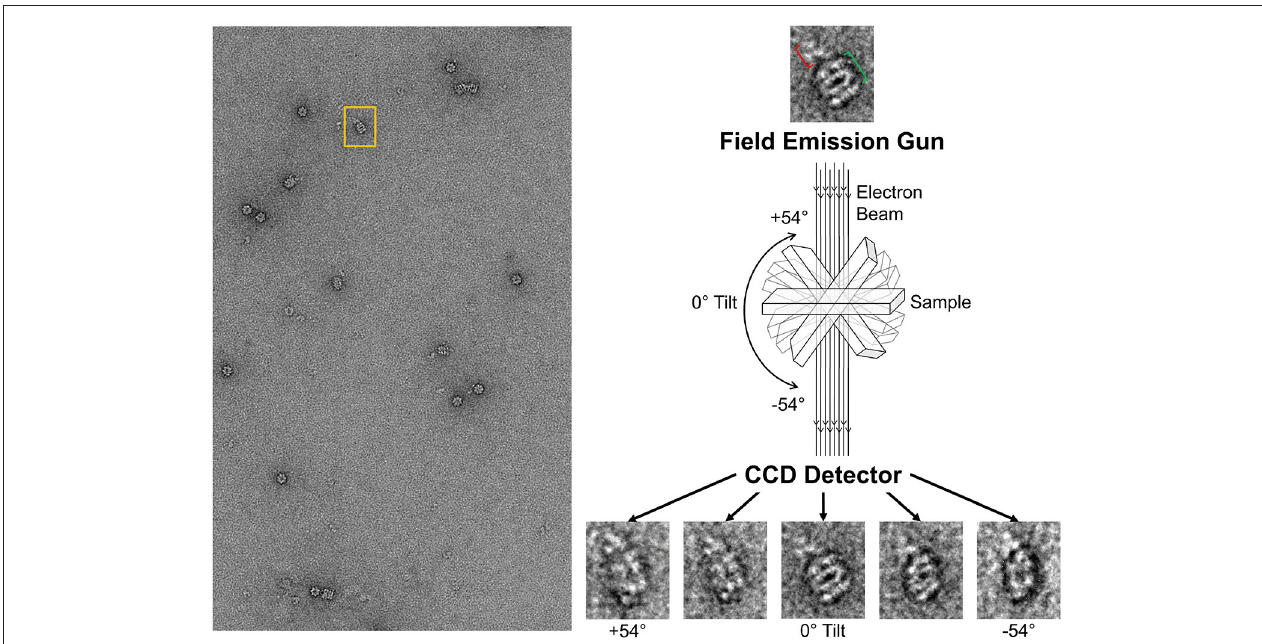
FIGURE 6 | Schematic of Tilt Series Image Capture. (Left) Representative micrograph of negative-stained GroEL bound to TeNT. The grid is scanned for isolated complexes to avoid protein overlap at high tilt angles. An appropriate complex is boxed in orange. (Right) Enlargement of boxed complex for detail. GroEL can be seen as four parallel bands (green bracket). Captured TeNT (red bracket) can be seen as white density above GroEL. This complex is then repeatedly imaged at 2 ◦ increments. Representative tilted image captures are shown at the bottom. Micrographs obtained at MU EMC.